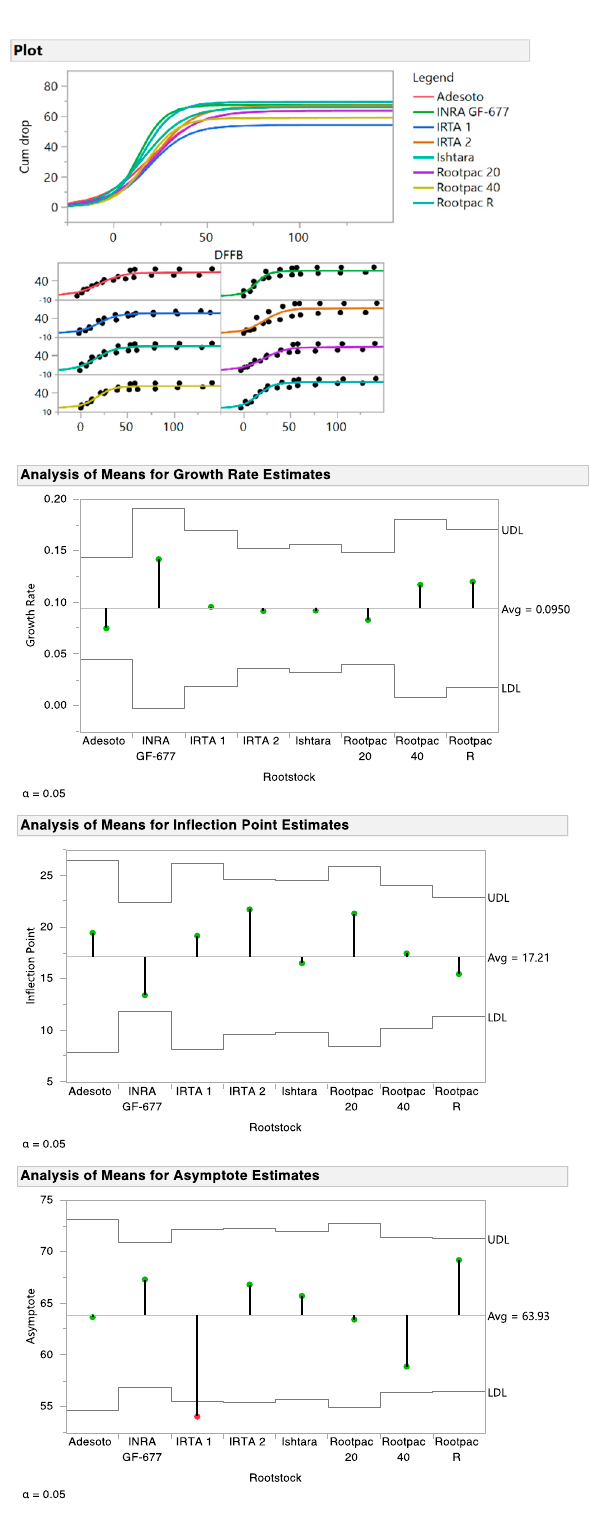
Figure 4. Fitted curves and parameter comparison for the logistic three-parameter models fitted to describe the relationship from bud break until 180 days after full bloom between cumulative fruit drop (%) and days from full bloom (DFFB) for ‘Marinada’ grafted onto Adesoto, Cadaman ® , Gar- nem ® , INRA GF-677, IRTA 1, IRTA 2, Ishtara ® , Rootpac ® 20, Rootpac ® 40, and Rootpac ® R rootstocks at Les Borges Blanques, Spain (P2). Data were recorded during 2017–2018.